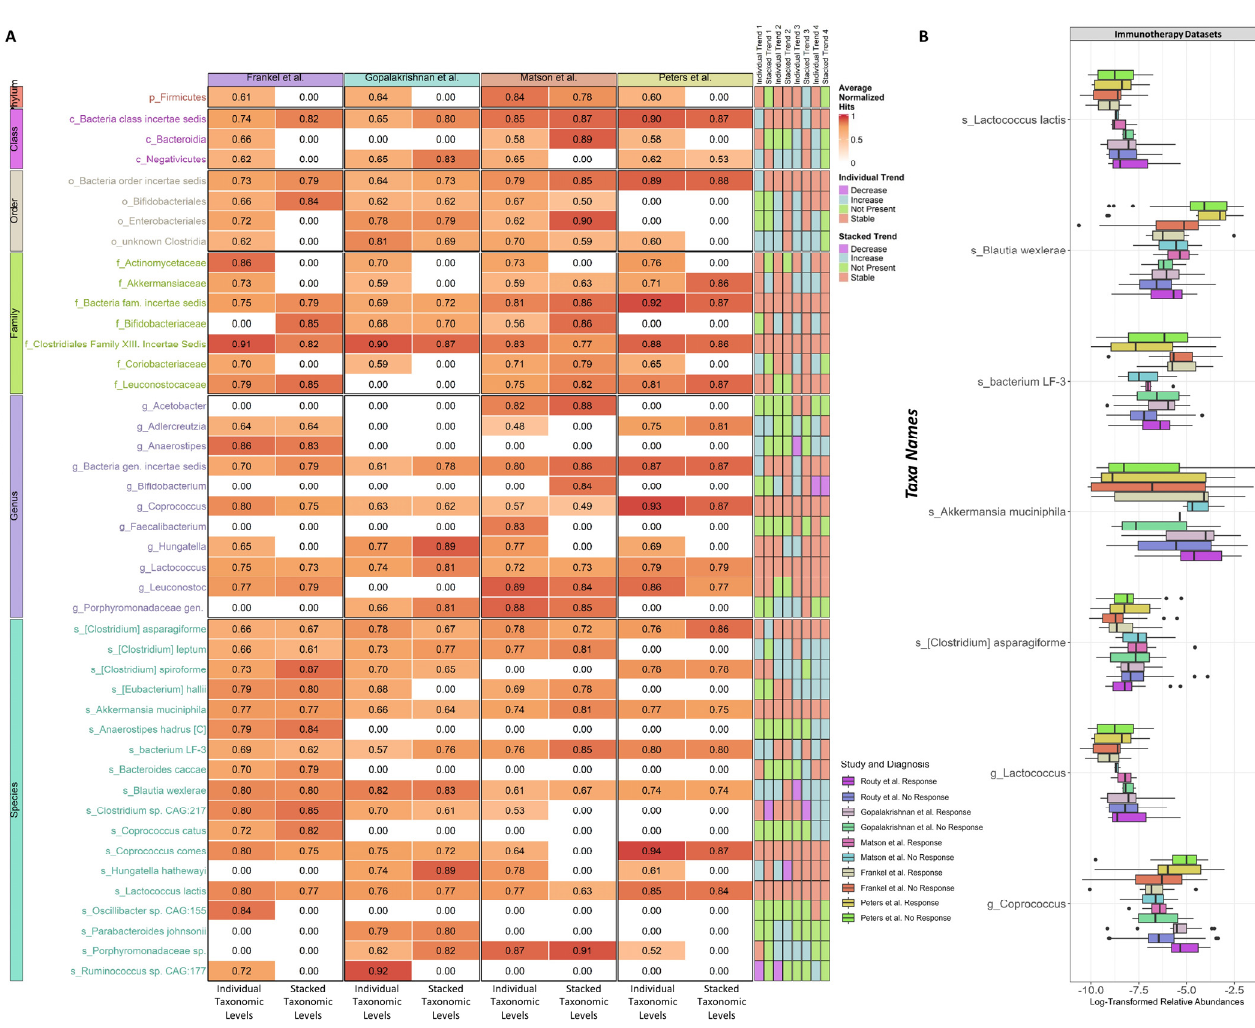
Figure 6. Top feature importance investigation changes for immunotherapy response datasets. ( A ) Heatmap for the changes in the top 44 features from the random forest feature selections result from individual taxonomic and stacked-taxa levels for colorectal cancer datasets across 50% of target samples in the source data. ( B ) Log-transformed relative abundances for the consistent taxa identified between the individual taxonomic and stacked-taxa for immunotherapy response. The solid black dots represent outliers. If there is no more than 0.15 change between the baseline and importance with 50% of target samples in the source for a taxon, it will be labeled as stable for the trend. For changes greater than 0.15 or less than − 0.15, the trend is labeled as increase or decrease, respectively. If the features were not selected as important from any of the models, these taxa are labeled as “Not Present”. The trend categories are divided into four groups corresponding to different target